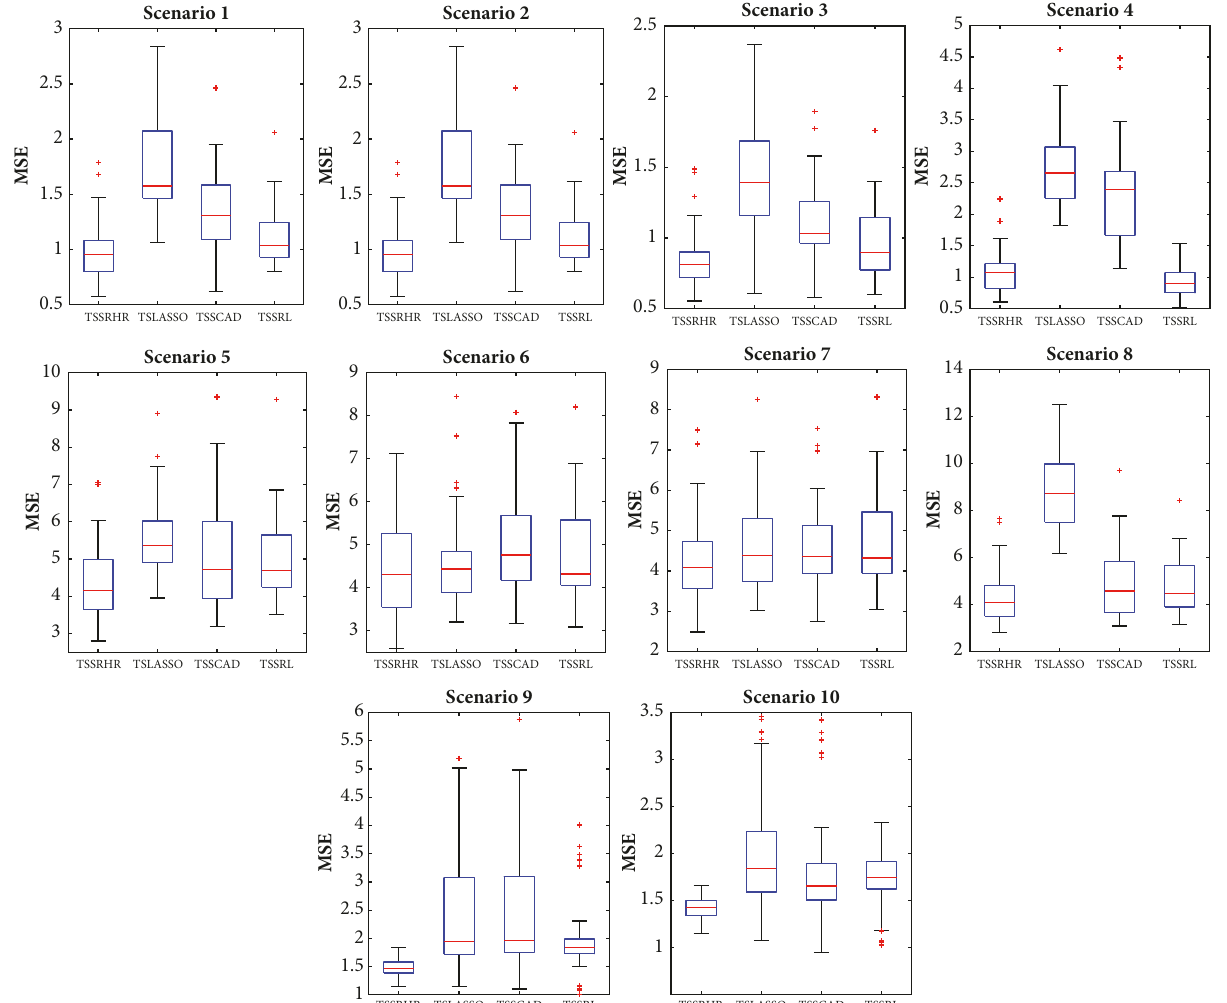
Figure 1: Boxplots of compared forecasting methods in Scenarios